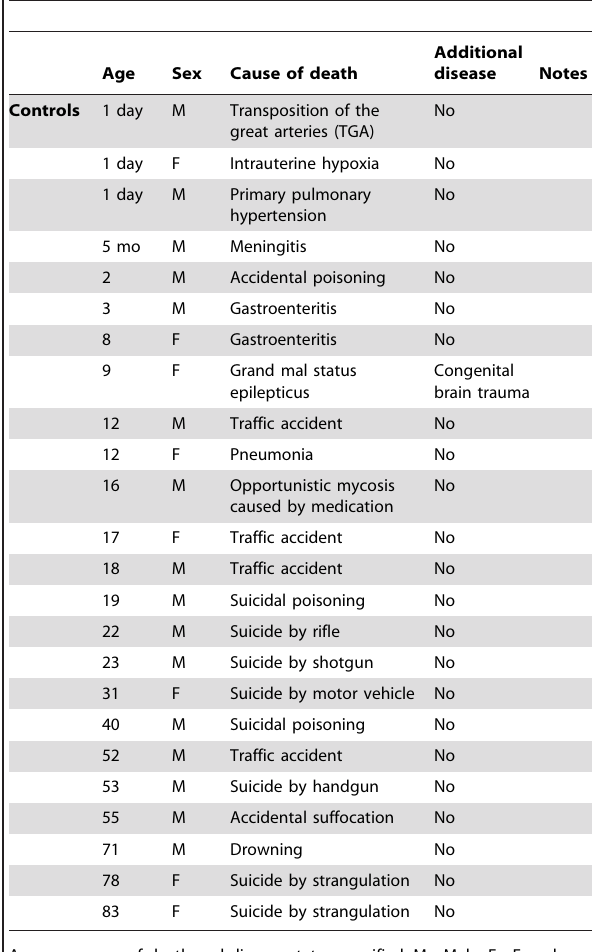
Table 1. Details of the left ventricular heart muscle samples from healthy controls used in this